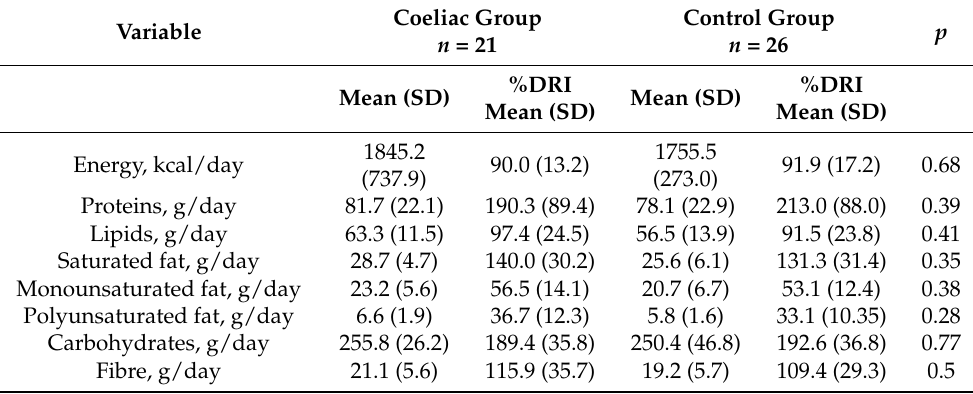
Table 6. Mean daily intake and percentage of dietary reference intake (%DRI) for total energy and macronutrients in CD and control